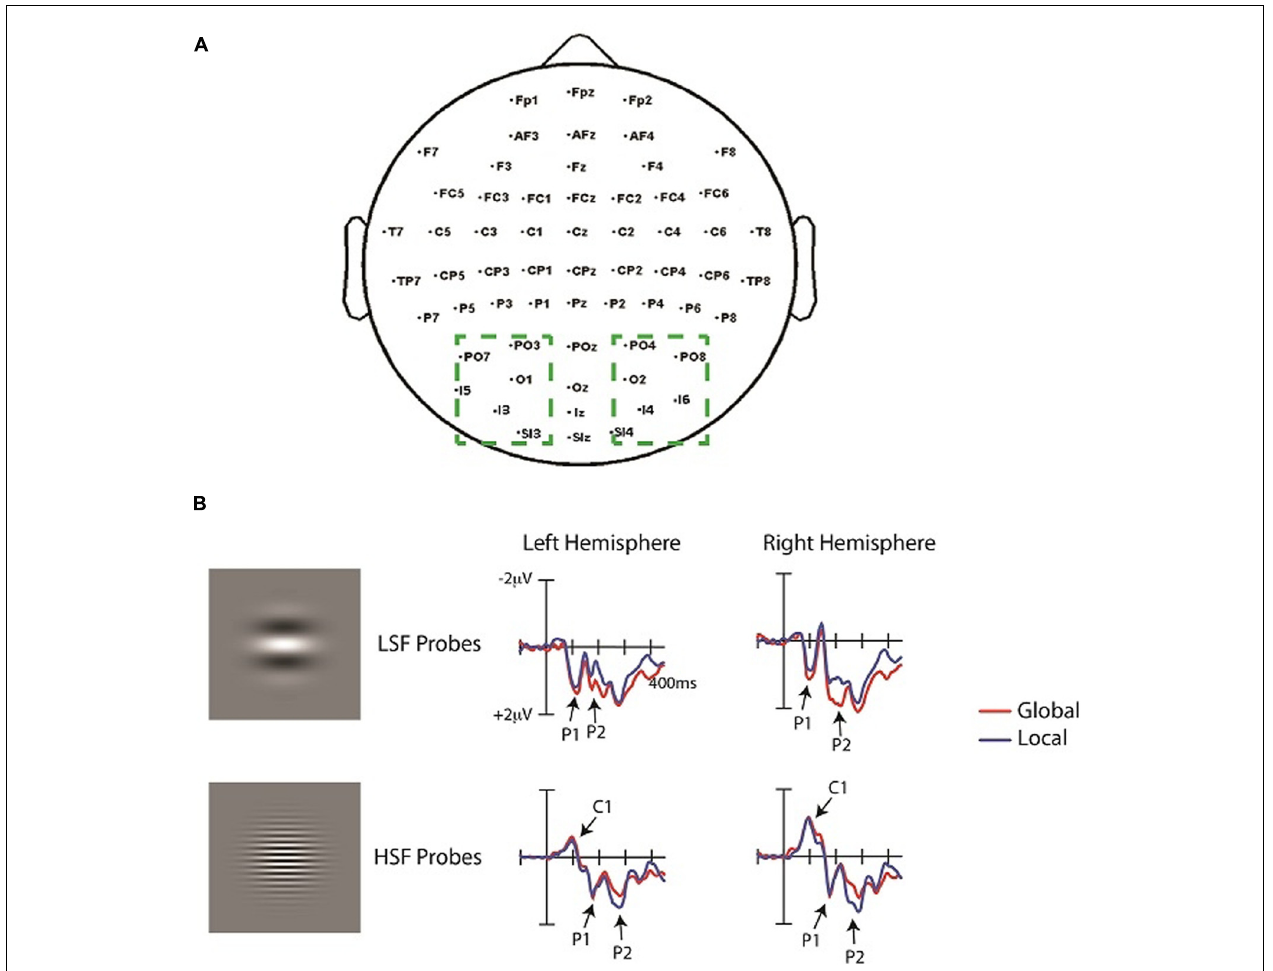
FIGURE 3 | (A) Topography of electrodes used in the experiment. Dashed boxes show the occipital electrodes averaged in the analyses. Left hemisphere (LH) and right hemisphere (RH) electrodes were averaged separately to yield two values (one for the LH and one for the RH) in each